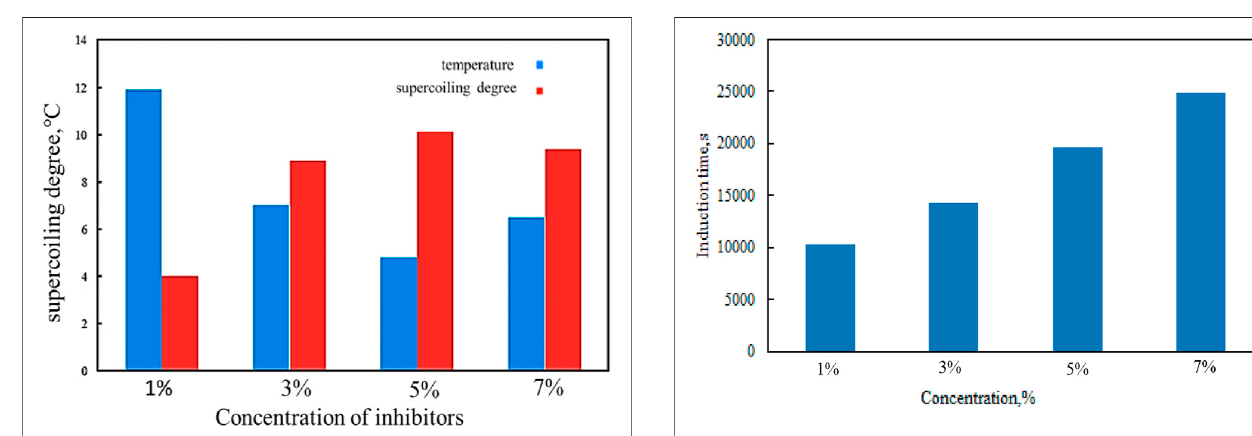
FIGURE13| Comparisonofinductiontimeofdifferentconcentrationsof inhibitors.